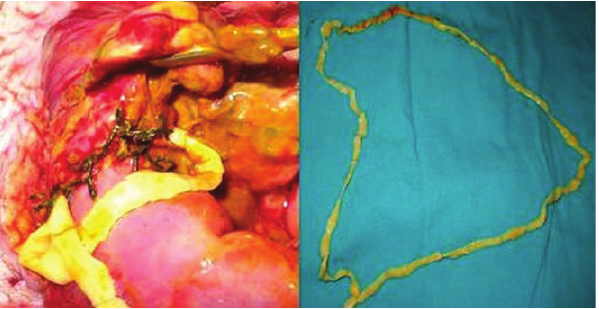
Figure 2 - Intraoperative view of the anastomotic leakage related to T. saginata